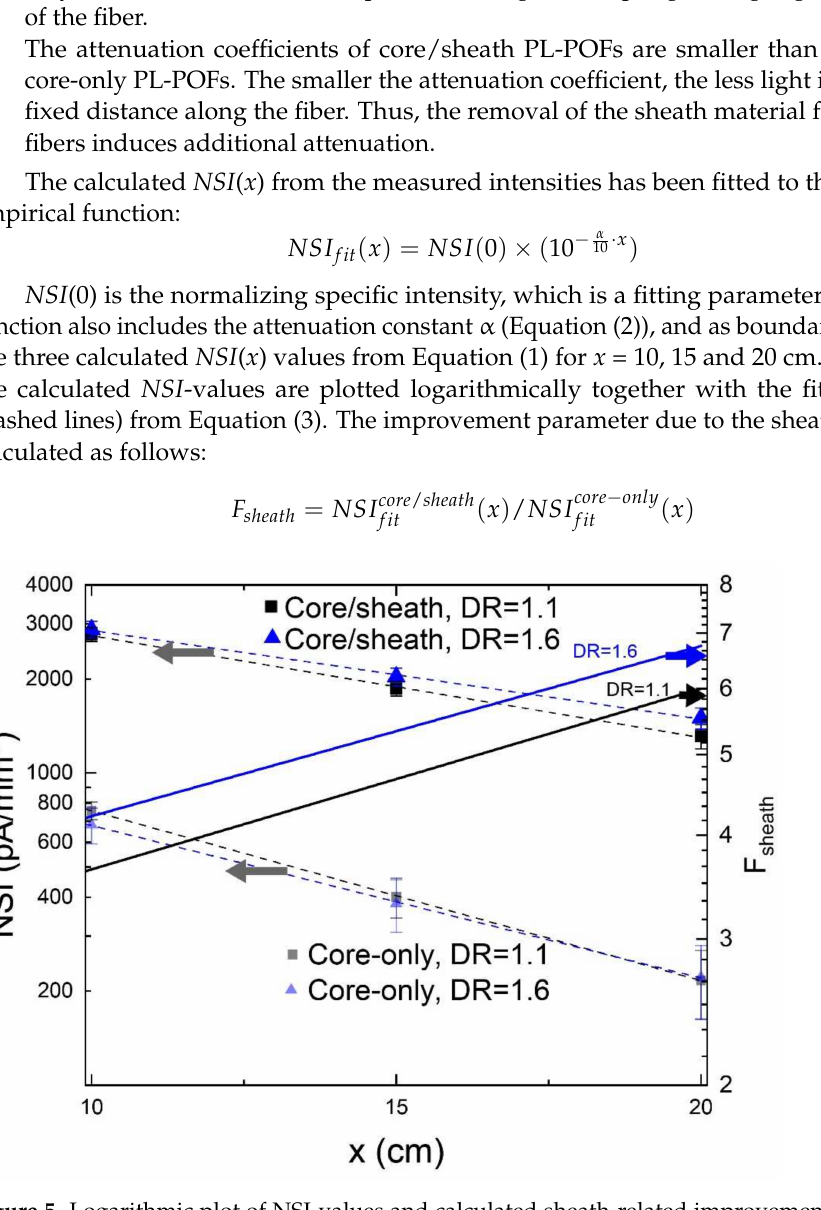
Figure 5. Logarithmic plot of NSI-values and calculated sheath-related improvement parameters, F sheath , for PL-POFs of DR = 1.1 and DR = 1.6. The fitting curves that are based on Equation (3) are shown as dashed